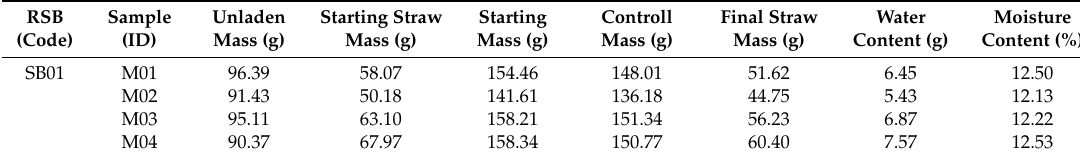
Table 6. Specimen straw moisture.